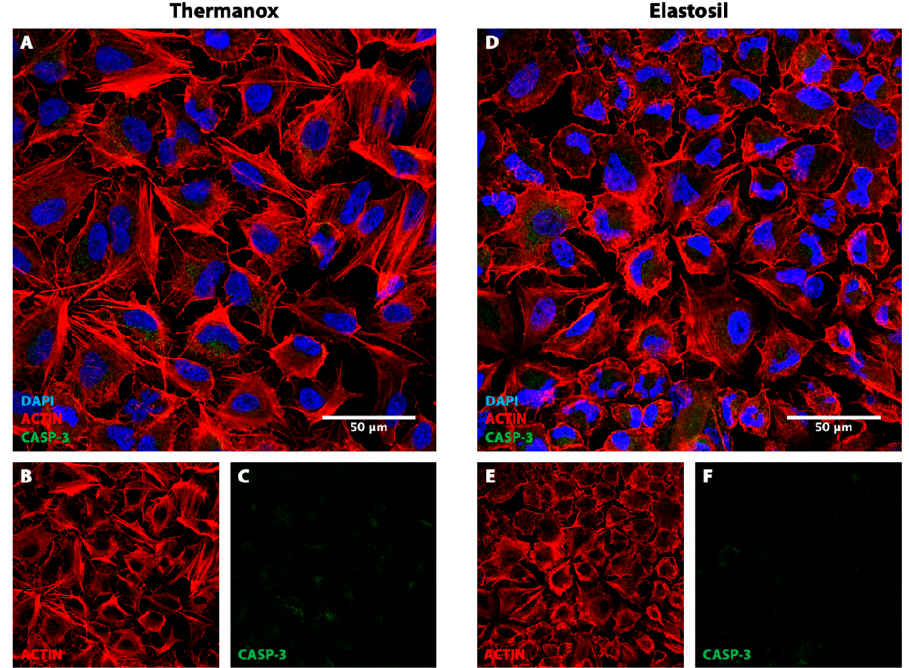
Figure 4. Immunofluorescence images of A549 cells stained for F-Actin (red) and caspase-3 (green) cultured on Thermanox™ Coverslips ( A – C ) and on Elastosil ® Film ( D – F ) after 72 h of culture. Magnification 40 × ( n = 20, representative images are here reported).